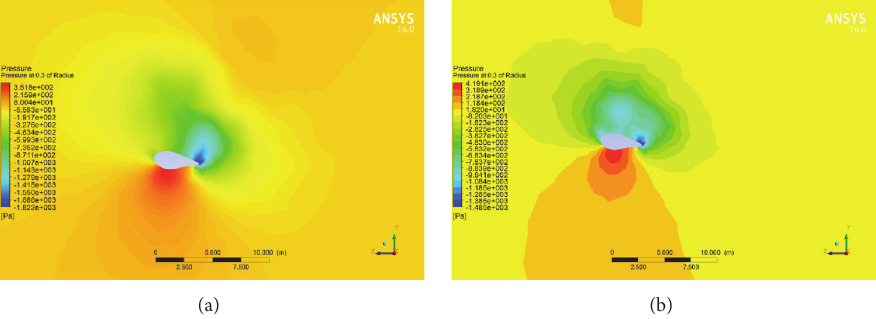
Figure 10: Pressure distribution at 2.5 seconds. Unidirection coupling (a) and bidirectional coupling